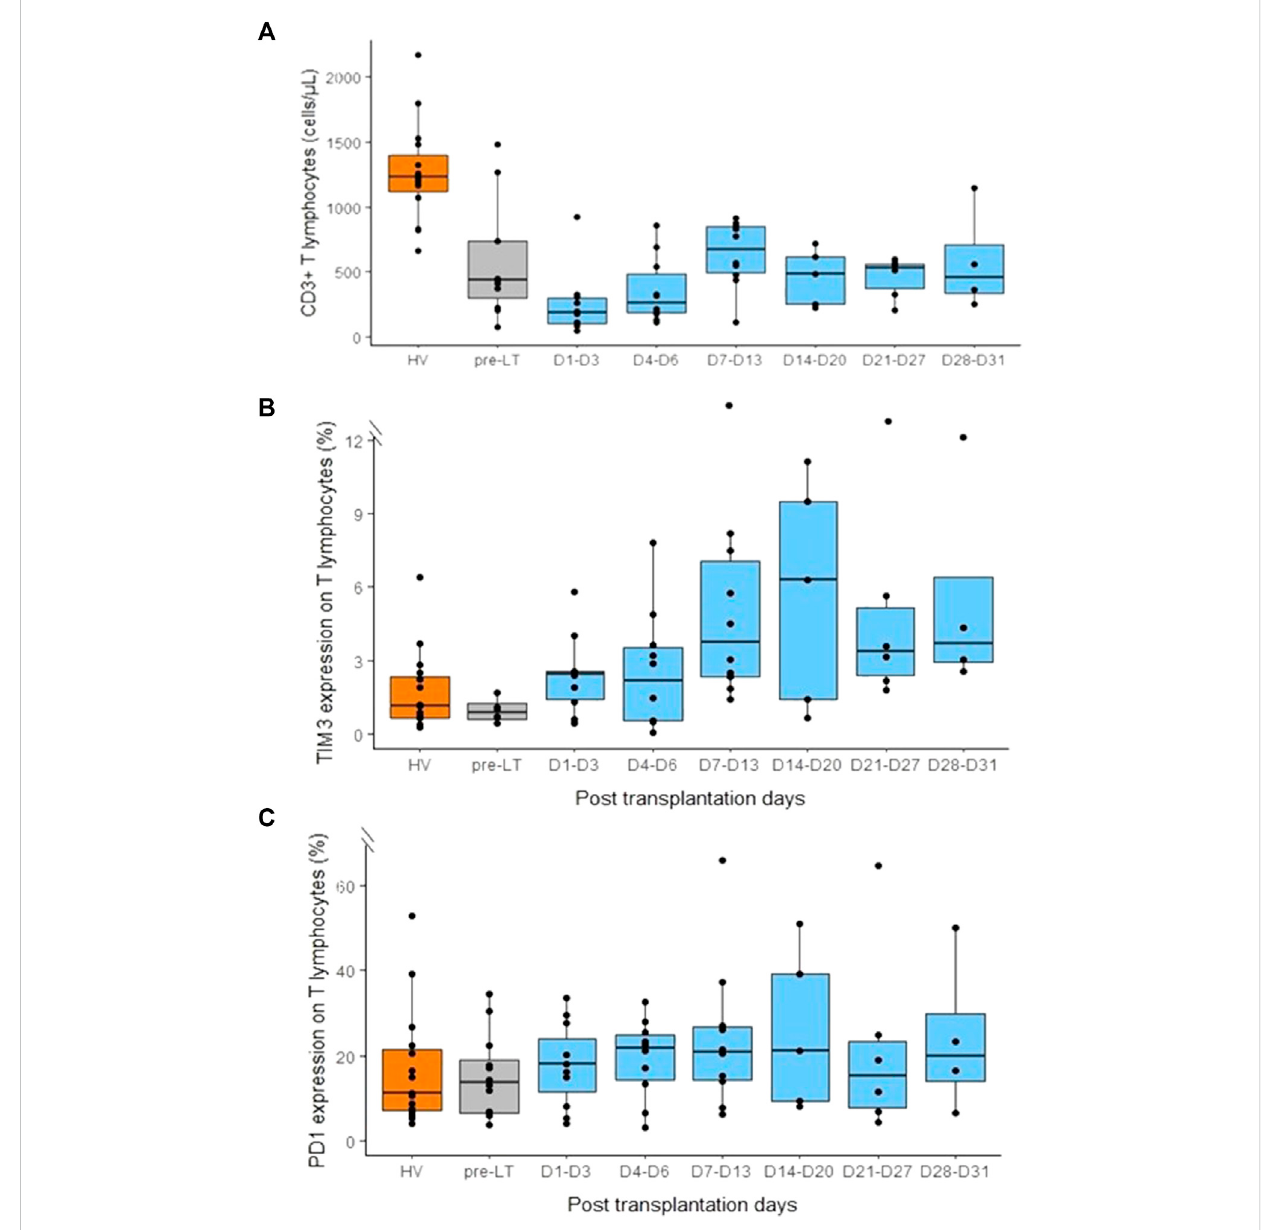
FIGURE 8 Monitoring of CD3+ T lymphocytes count and PD-1 and TIM3 expression on CD3+ T lymphocytes in peripheral blood before and after liver transplantation. (A) CD3+Tlymphocytescount inhealthy volunteers (HV, n = 15),pre-transplantpatients (pre-LT, n =11)and followingtransplantationat differenttimepoints(day1today3, n =10;day4today6, n =10;day7today13, n =10;day14today20, n =5;day21today27, n =6;day28today31, n = 4). (B) Percentage of TIM3 expression on CD3+ T lymphocytes in healthy volunteers (HV), pre-transplant patients (pre-LT) and following transplantation at different time points. (C) Percentage of PD-1 expression on CD3+ T lymphocytes in healthy volunteers (HV), pre-transplant patients (pre-LT) and following transplantation at different time points. Pre-transplant data only concern patients that bene fi ted from